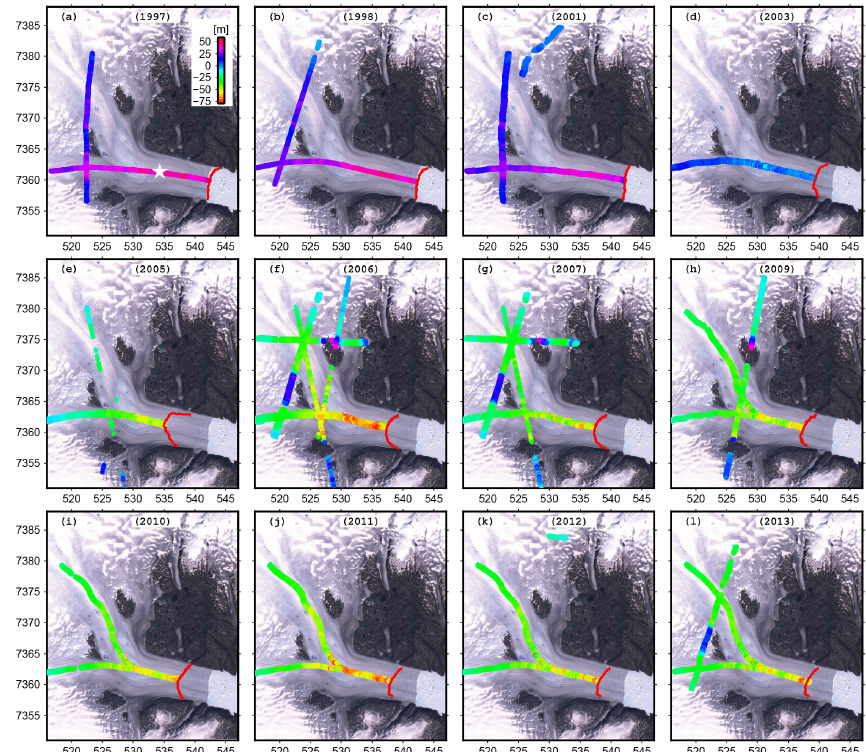
Figure 4. Elevation changes relative to 1981 on Helheim Glacier. Colours indicate the change in Helheim Glacier elevation relative to 1981 along the track lines. The colour bar is in metres. Uncertainties are 5.1m. Areas near the glacier margin show the greatest elevation change. The red line shows the position of the calving front. The panels show elevation changes of Helheim Glacier during (a) 1981–1997, (b) 1981–1998, (c) 1981–2001, (d) 1981–2003, (e) 1981–2005, (f) 1981–2006, (g) 1981–2007, (h) 1981–2009, (i) 1981–2010, (j) 1981– 2011, (k) 1981–2012, (l) 1981–2013. The white star in (a) represents the location of the time series shown in Fig. 7a. The background map is a Landsat7 Enhanced Thematic Mapper (ETM) + “true color” image from 2 August 2001. The axes displays UTM zone 24 coordinates in